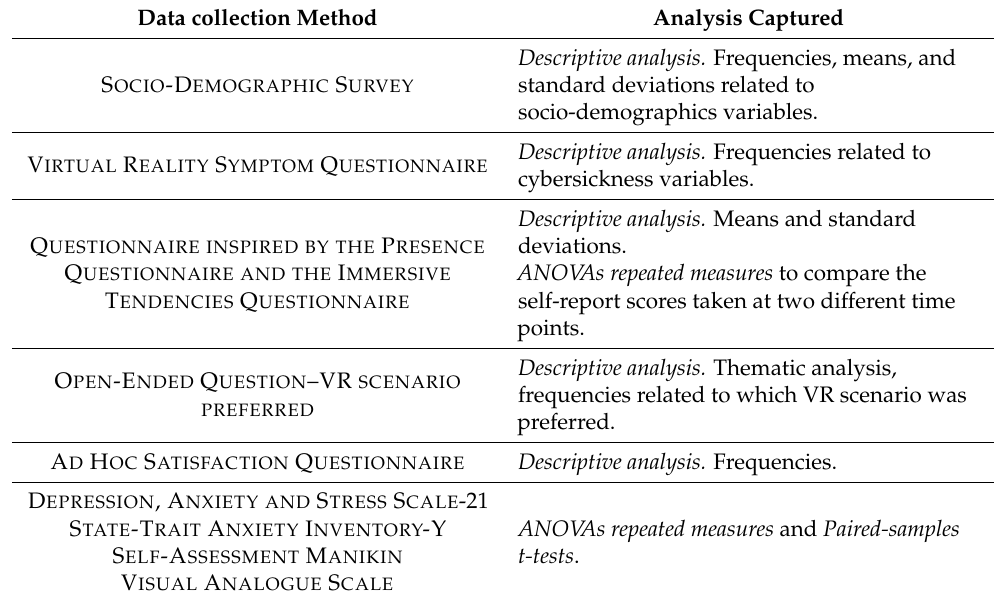
Table 1. Data collection method and